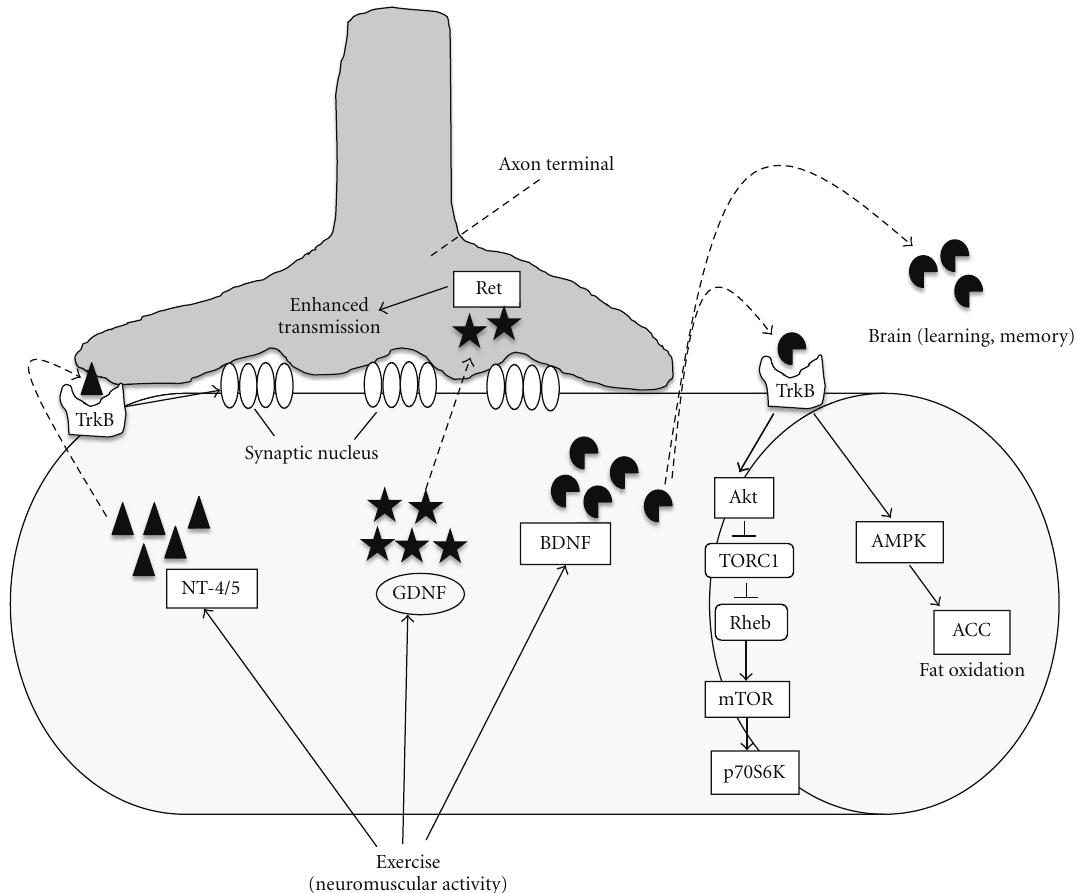
Figure 2: Schematic diagram of the functional role of skeletal muscle-derived neurotrophic factors after exercise. Exercise (neuromuscular activity) increases BDNF expression in skeletal muscle. In the patients with spinal cord injury, BDNF stimulates protein synthesis by activating Akt/mTOR/p70S6K pathway through TrkB receptor on muscle membrane. BDNF also promotes the fat oxidation through AMPK- ACC signaling. BDNF produced by skeletal muscle after exercise may circulate into brain to improve the impaired learning and/or